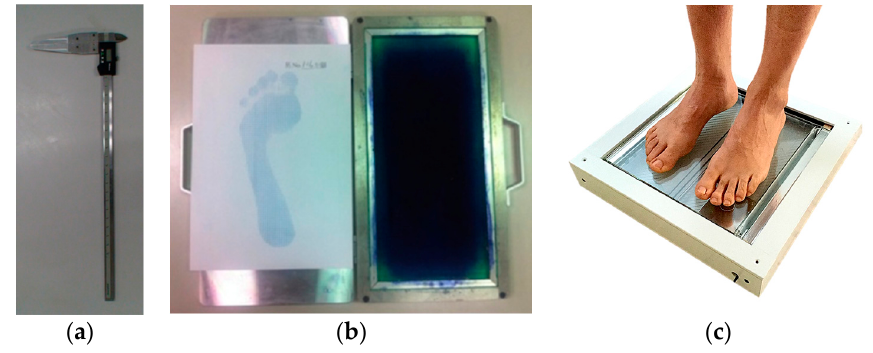
Figure 1. Traditional devices used for the measurement of the foot: ( a ) Digital caliper; ( b ) Ink mat; ( c ) Digital podoscope (modified from [3]).